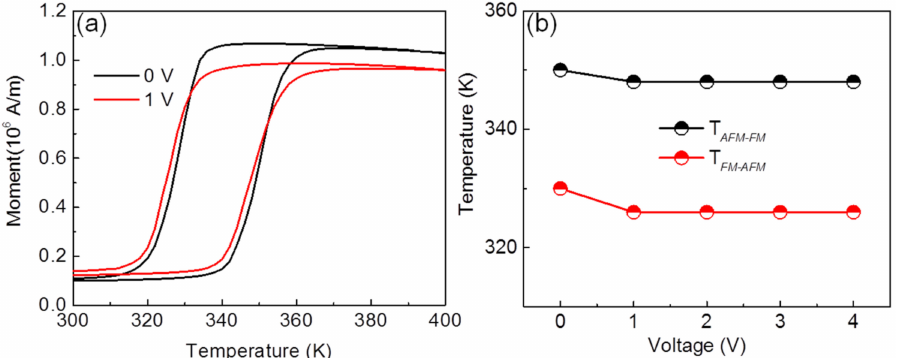
Figure 2. ( a ) Temperature-dependent magnetization without and with an applied voltage of 1 V for the FeRh thin film at 2 kOe. ( b ) Voltage-dependent T AFM-FM and T FM-AFM of FeRh on heating and cooling